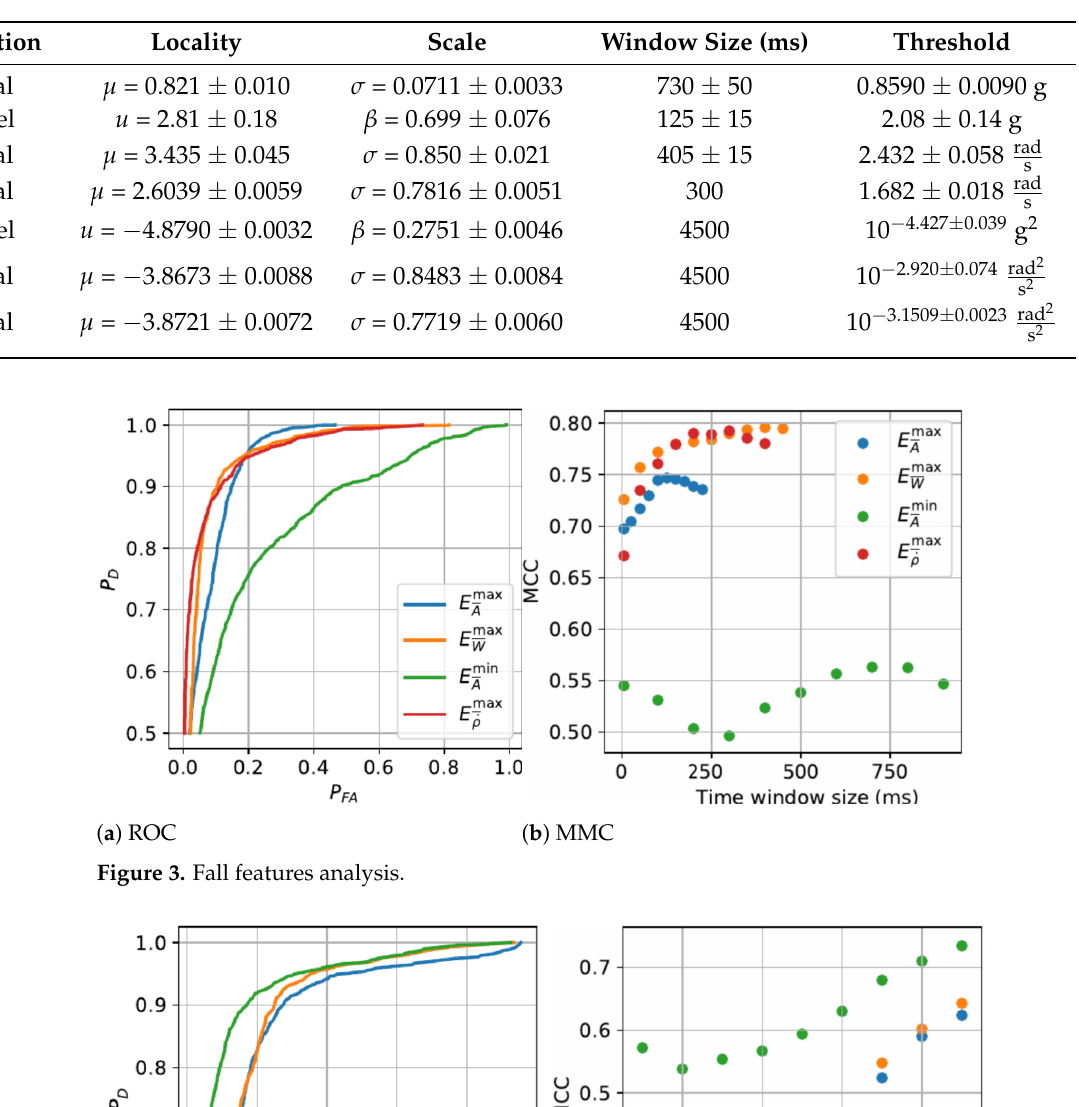
Table 2. State features detection characterization.